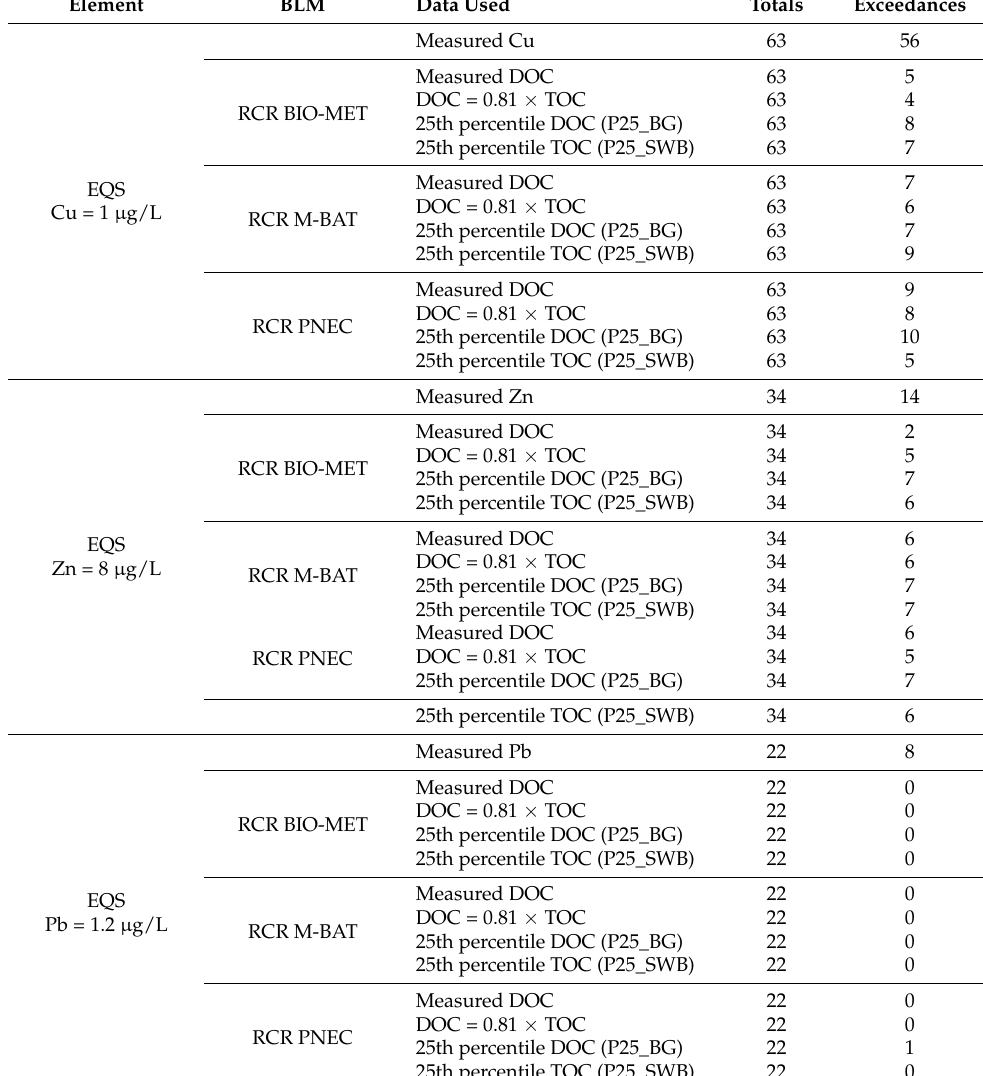
Table 3. The exceedances for Cu, Zn, Ni and Pb in the studies of Bulgarian surface water bodies after the application of the